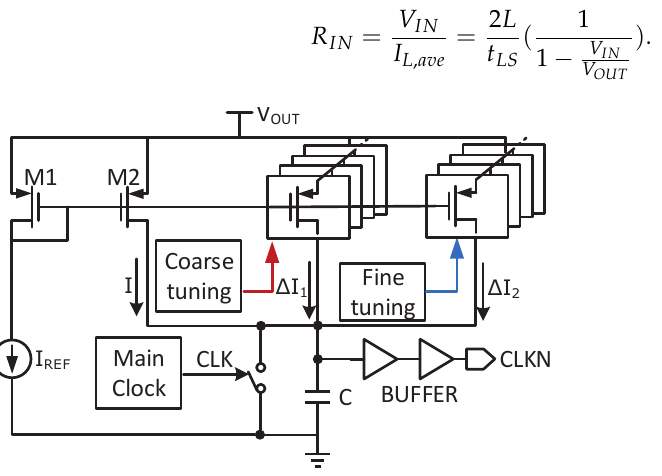
Figure 3. The three phases of the